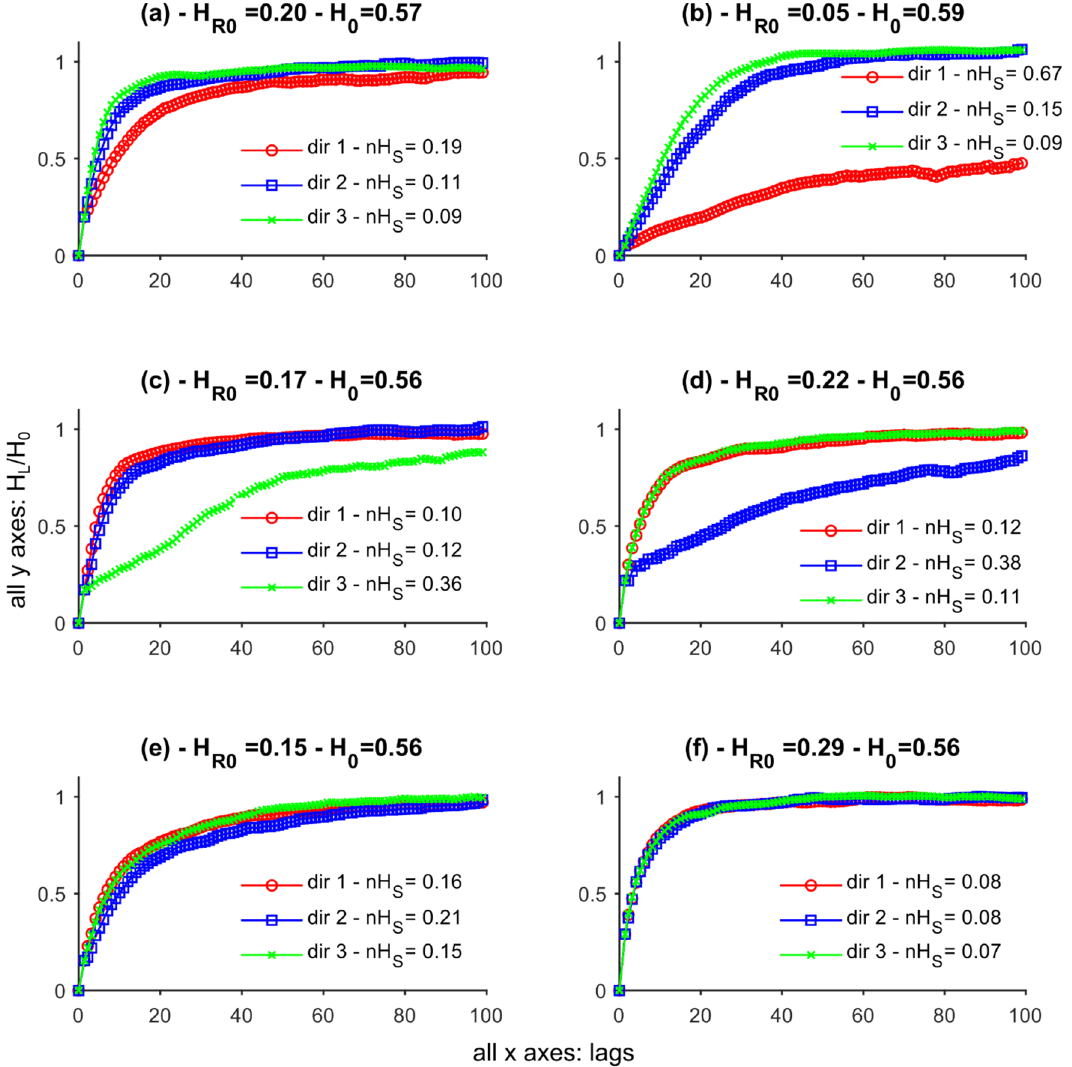
Figure 6. Normalised entrograms of the six analysed training images presented in Figure 5.